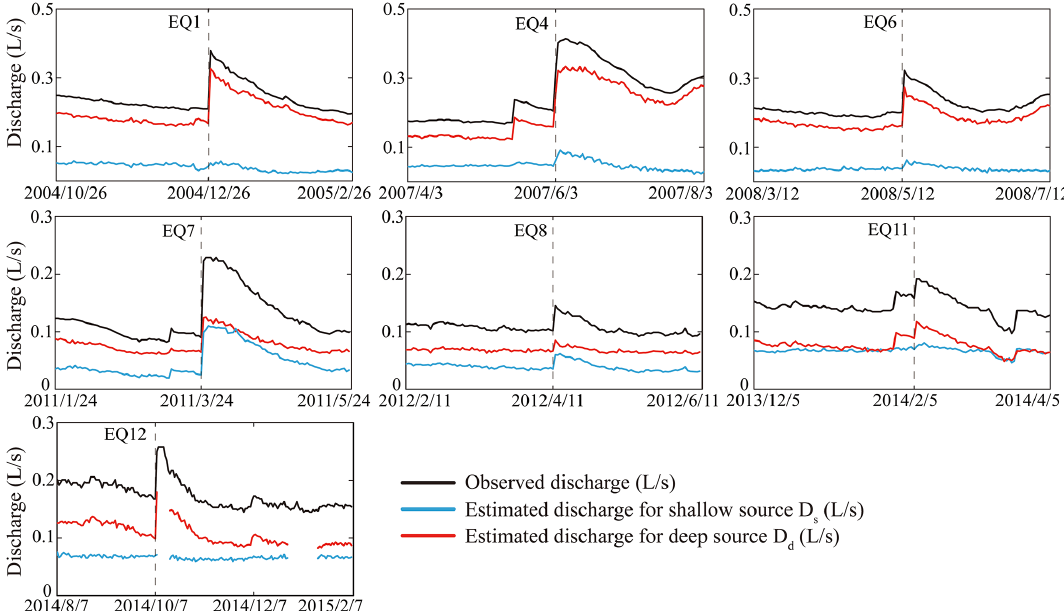
Figure 8. Observed and estimated discharge for shallow and deep source following selected